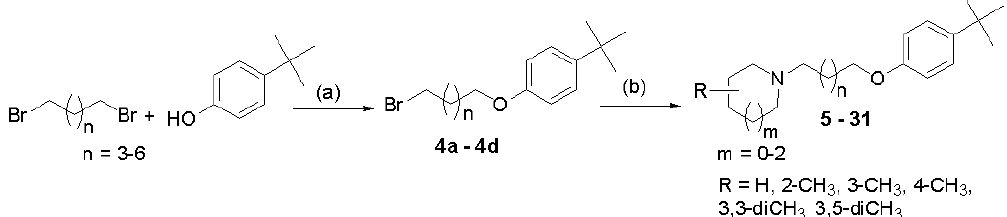
Scheme 1. General synthetic pathway of synthesized compounds 5 – 31 . Reagents and conditions: ( a )